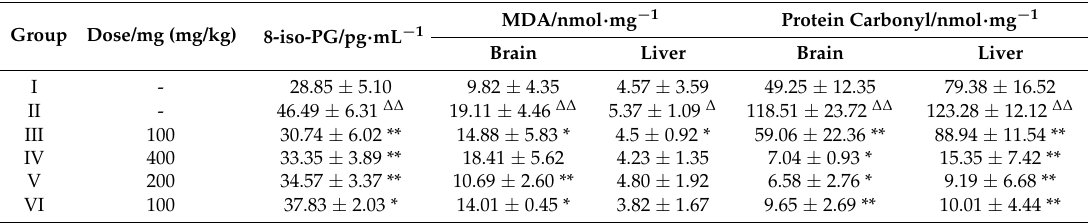
Table 2. Effects of Paeonia rockii flower extracts on 8-iso-PG from blood serum, brain and liver MDA, and protein carbonyl in D -galactose-induced mice.